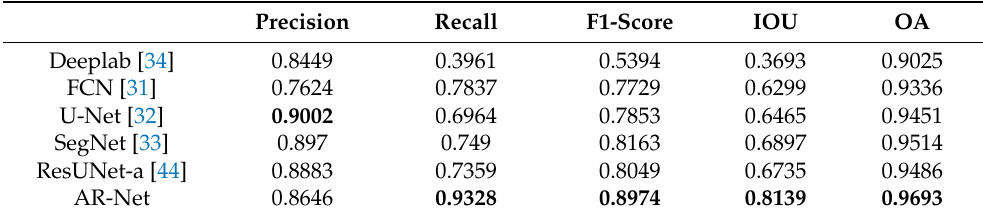
Table 5. Performance comparisons of the six semantic segmentation algorithms for the large-scale multibeam images. The bold numbers represent the maximum value in each